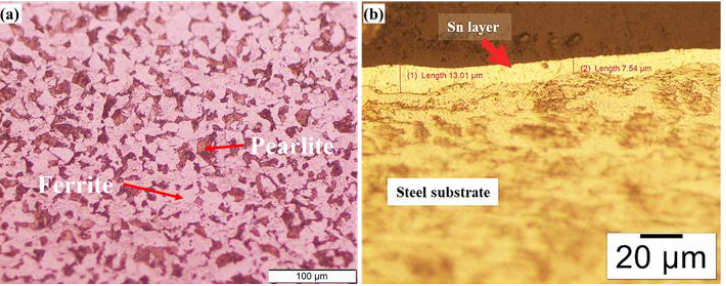
Figure 1. Optical microstructure of ( a ) carbon steel substrate and ( b ) initial microstructure of pre- tinned steel before dipping process.